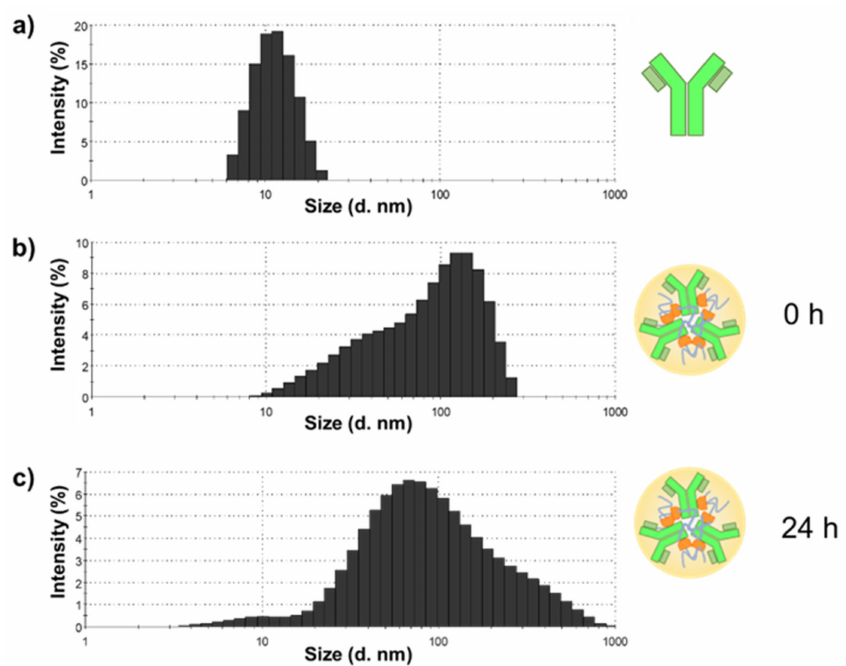
Figure 4. Confirmation of particle size of IgG–PNIPAAm conjugates determined by DLS at 25 ◦ C. ( a ) IgG, ( b ) IgG–PNIPAAm stood for 0 h, ( c ) IgG–PNIPAAm stood for 24